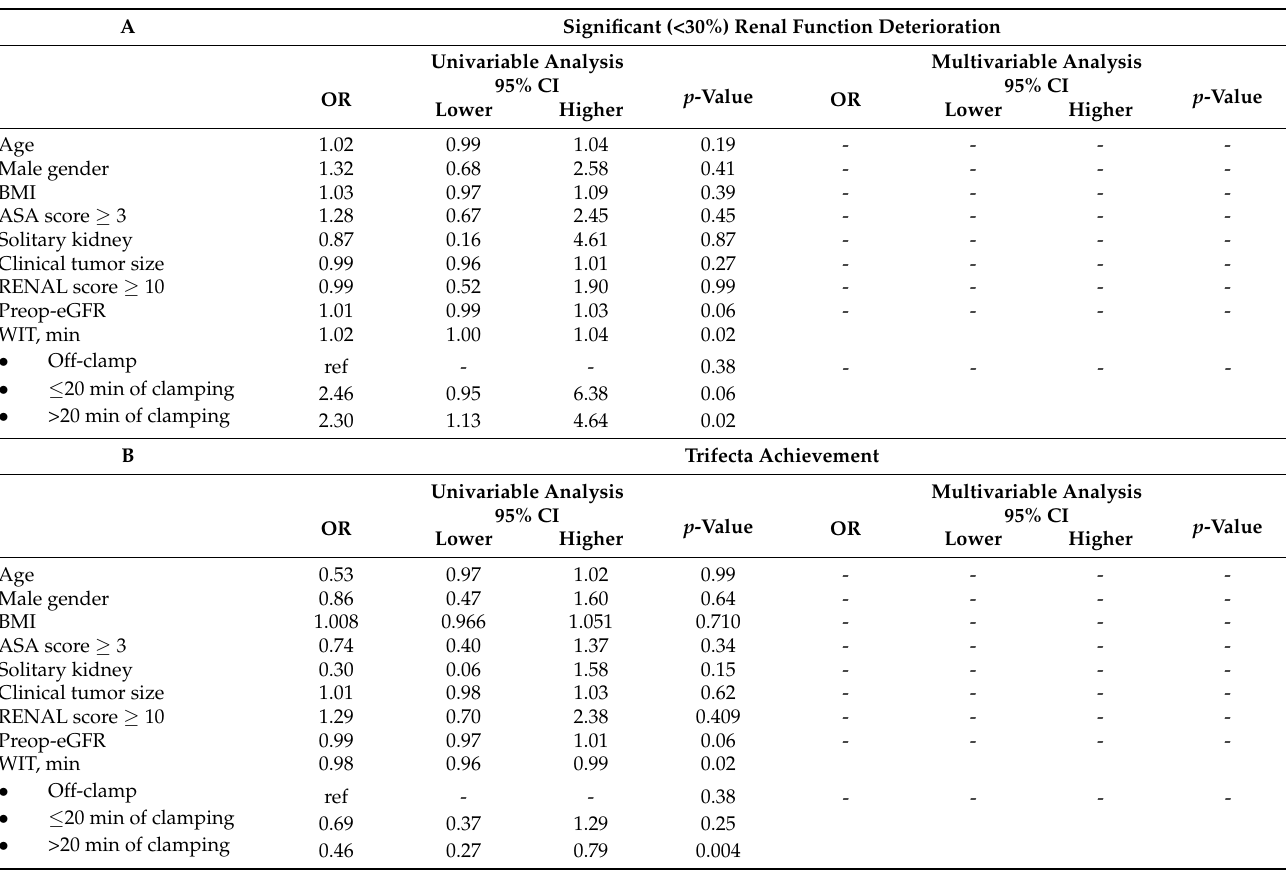
Figure 2. Severe renal function deterioration (sRFD) and Trifecta rates according to WIT. The PSM analysis generated two cohorts of 89 patients homogeneous for age, ASA score, preoperative eGFR, and RENAL score (all p > 0.21) (Table 1). Compared to onRAPN, OT was significantly shorter in the offRAPN cohort ( p < 0.001), the incidence of sRFD was lower ( p = 0.01), and the Trifecta rate higher ( p = 0.01). In a crude analysis, >20 min of hilar clamping was associated with a significantly higher risk of sRFD (OR: 2.30; 95%CI: 1.13–4.64; p = 0.02) and with reduced probabilities of achieving the Trifecta (OR: 0.46; 95%CI: 0.27–0.79; p = 0.004) (Table 2). Table 2. Logistic regression analyses to identify predictors of severe renal function deterioration (sRFD) ( A ) and Trifecta achievement ( B ) probabilities.